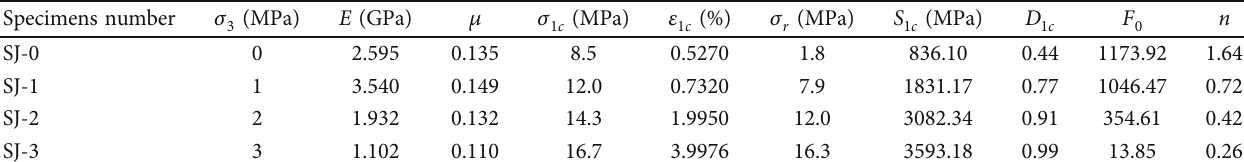
Table 1: Parameters of DCM.